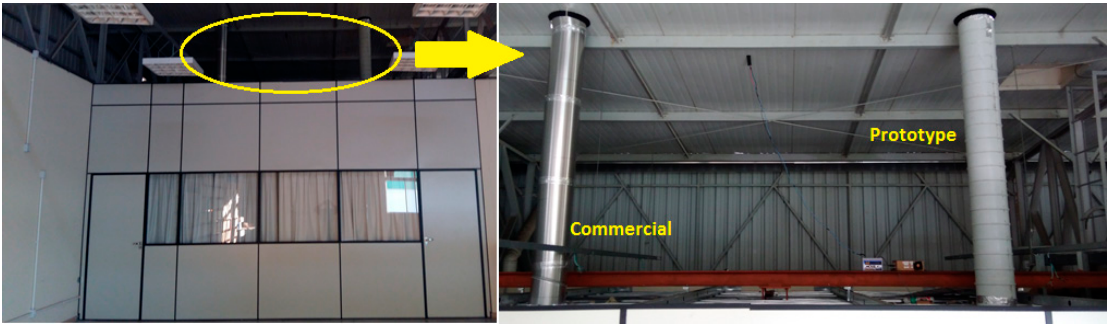
Figure 4. Arrangement of the reflective tubes in the test environment.